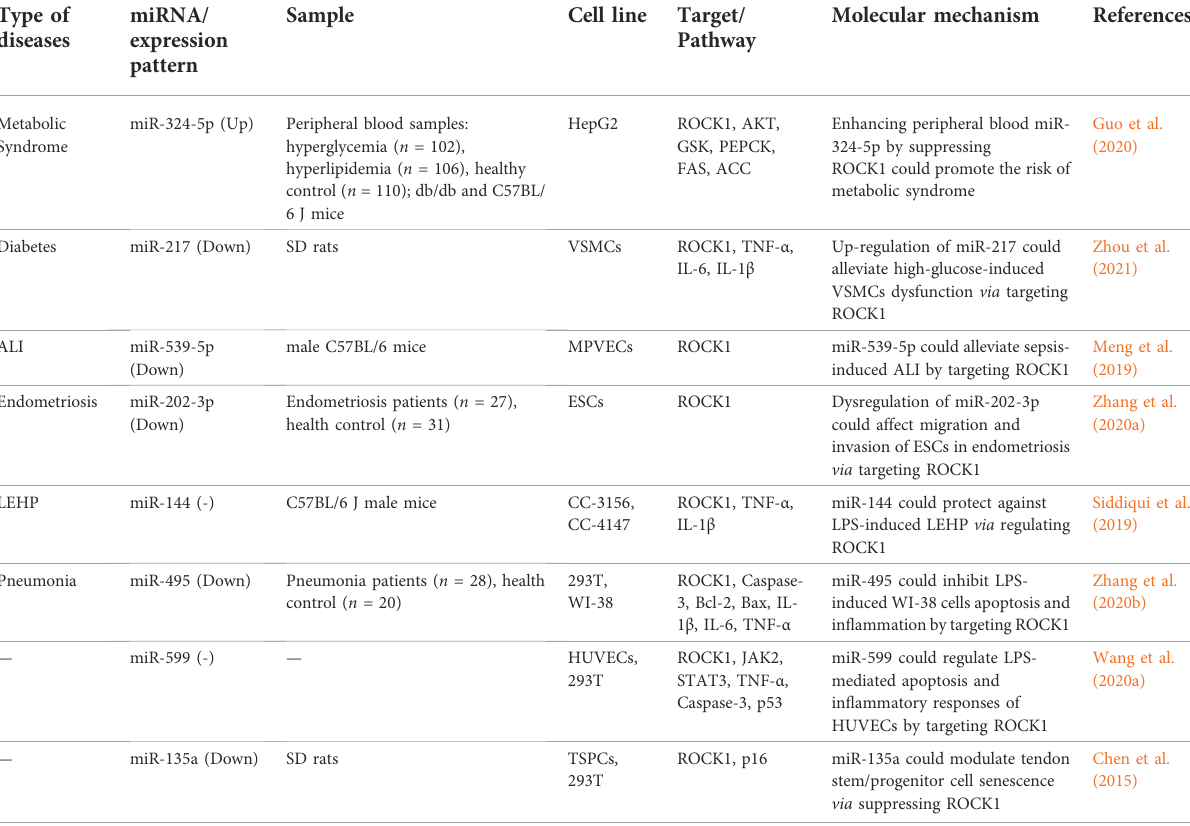
TABLE 1 ROCK1-interacting miRNAs in non-malignant conditions (ALI: acute lung injury, LEHP: LPS-induced lung endothelial hyperpermeability). Type of